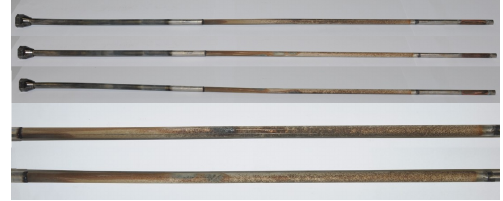
Figure 8. Test section after experiments